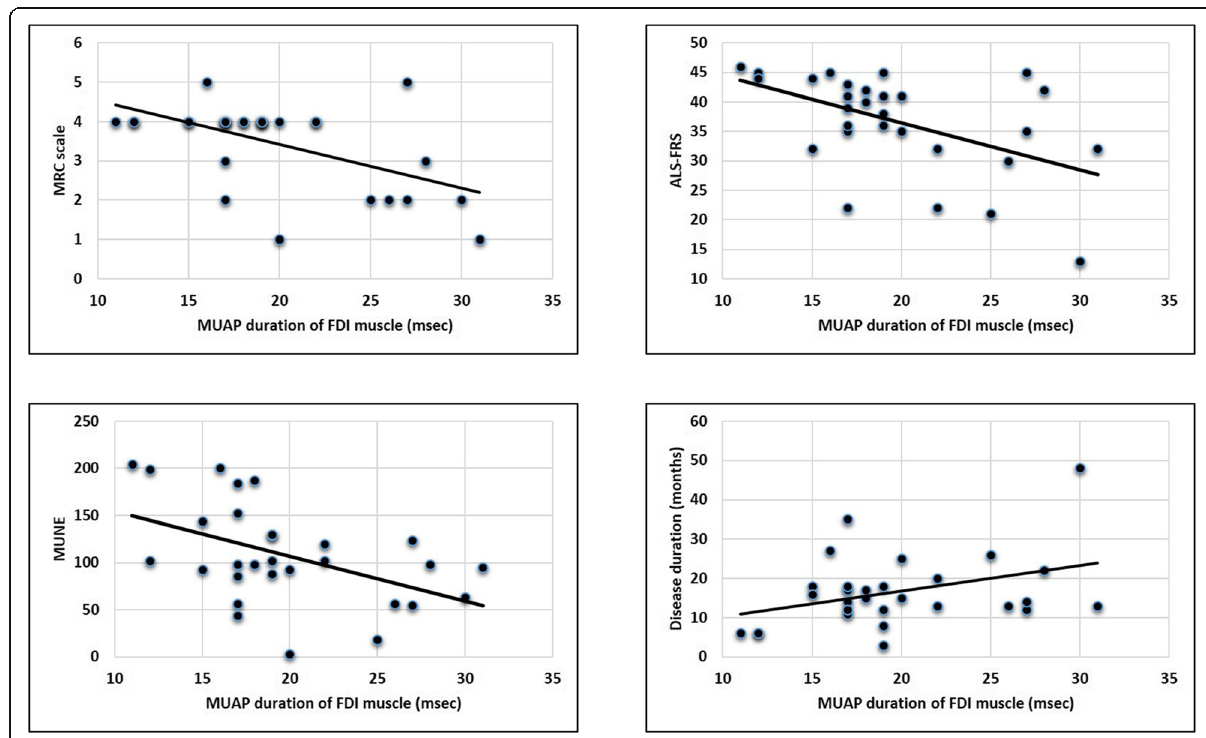
Fig. 2 Correlation between the MRC scale and the MUAP duration ( upper left ); the ALSFRS and the MUAP duration ( top right ); MUAP duration and MUNE ( bottom left ); the MUAP duration and disease